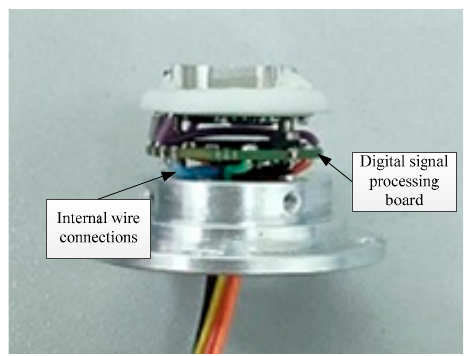
Figure 4. The internal structure of the radar.